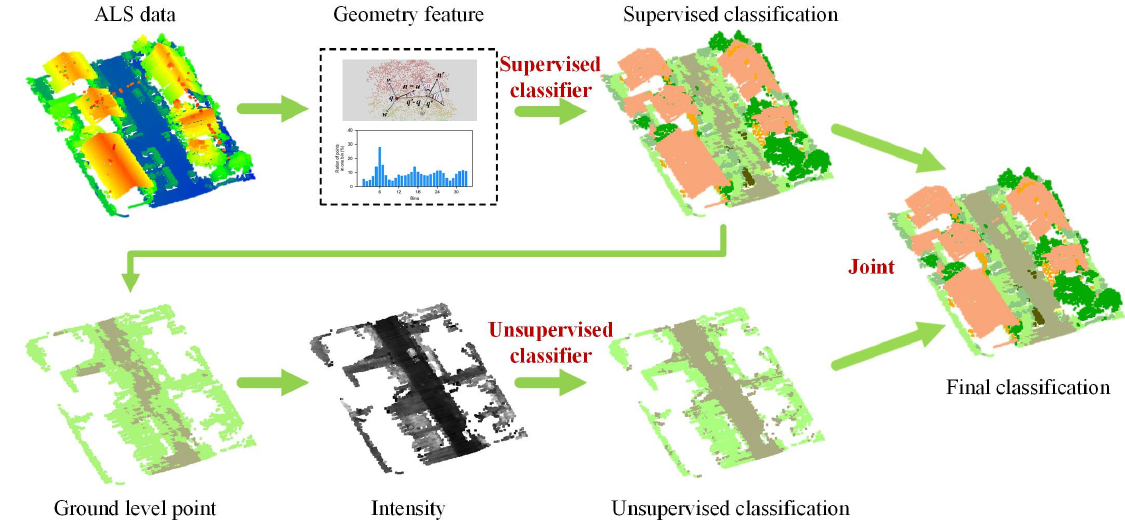
Figure 2. Flowchart of the proposed method. The above row shows the supervised learning for geometry information; the bottom row shows unsupervised learning for intensity information, and the final col joint the supervised and unsupervised classification results.